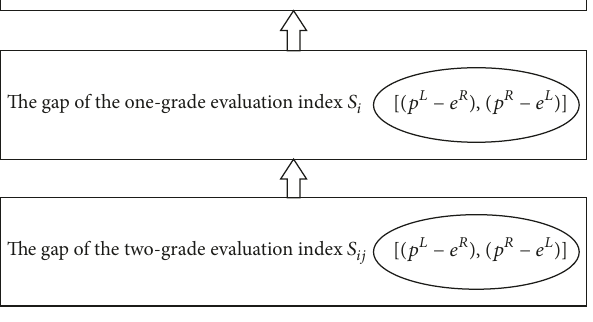
Figure 1: Product quality evaluation